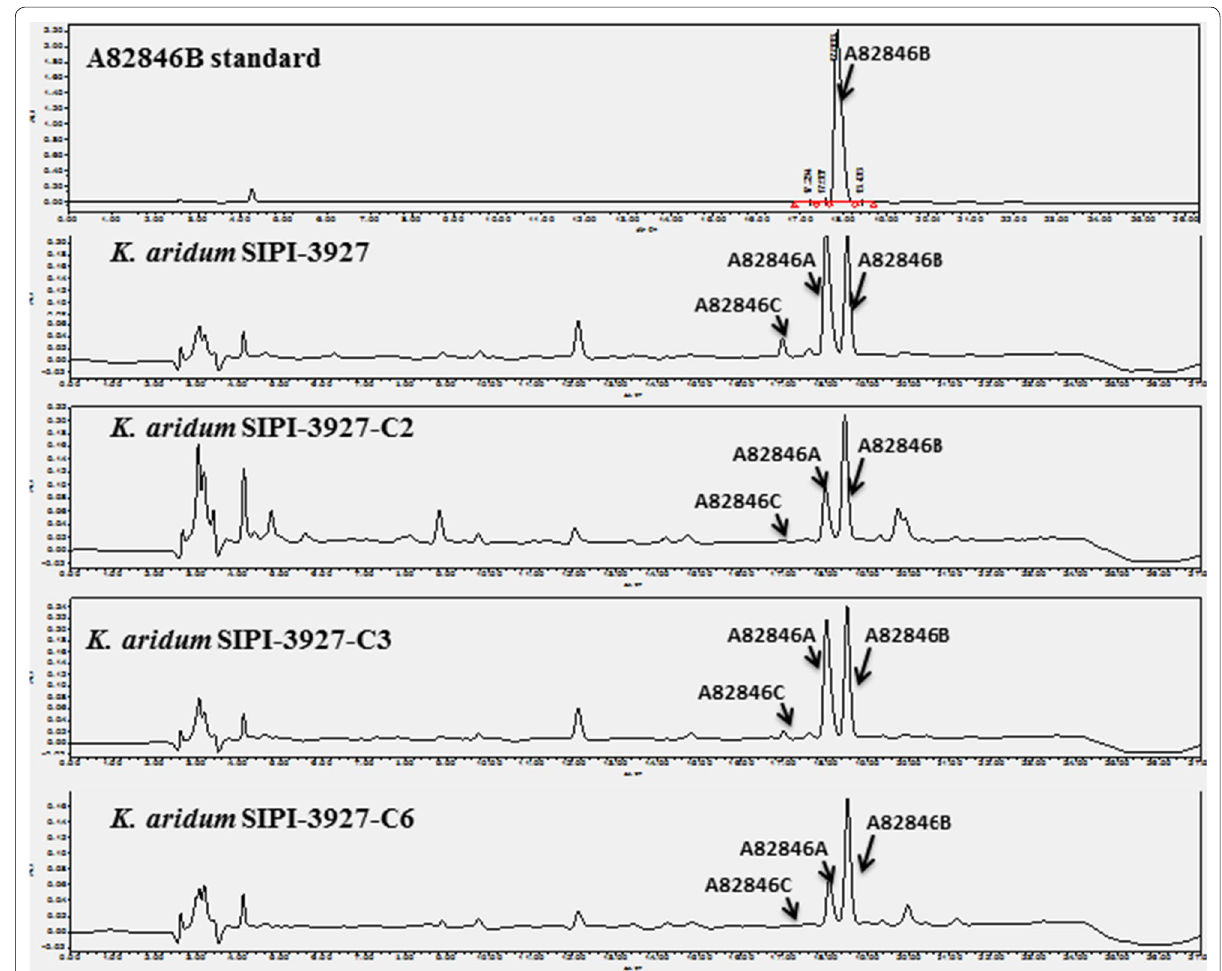
Fig. 4 HPLC analysis of the A82846 components production in fermentation broths